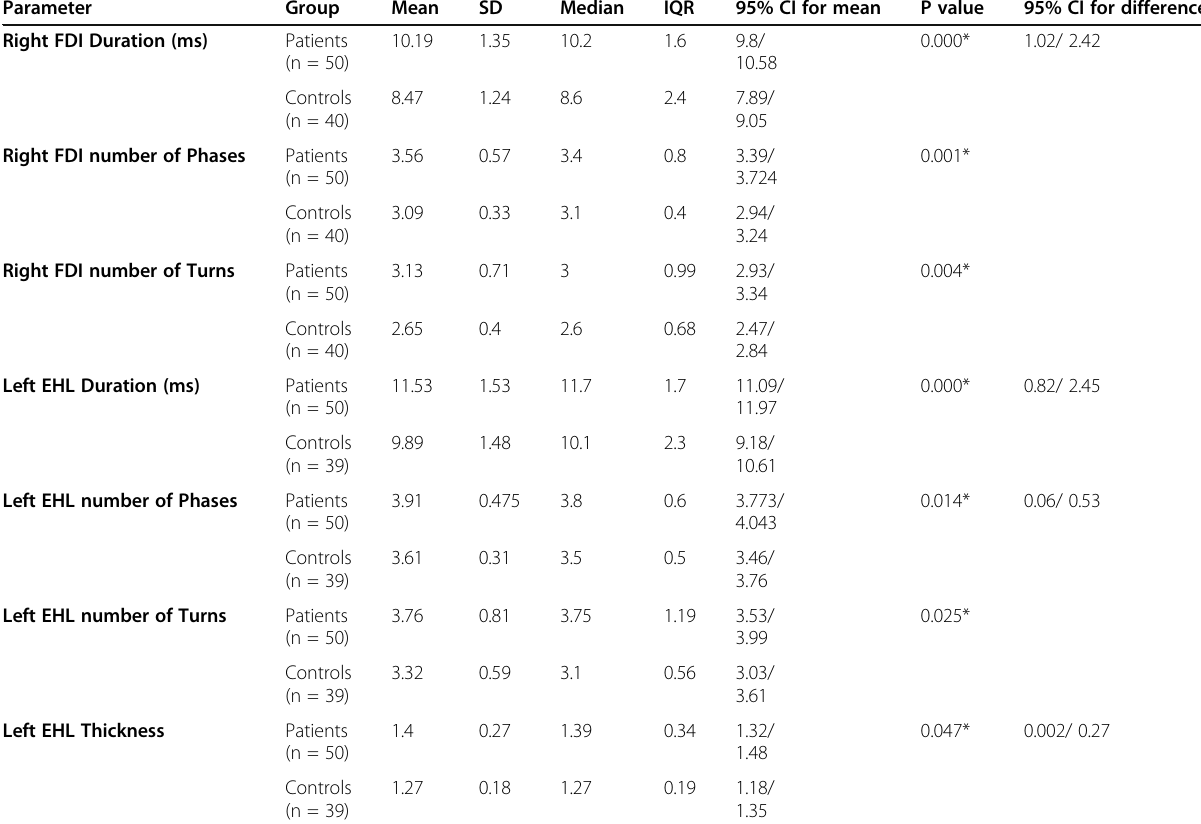
Table 4 Significant differences of quantitative MUP findings between the two groups Parameter Group